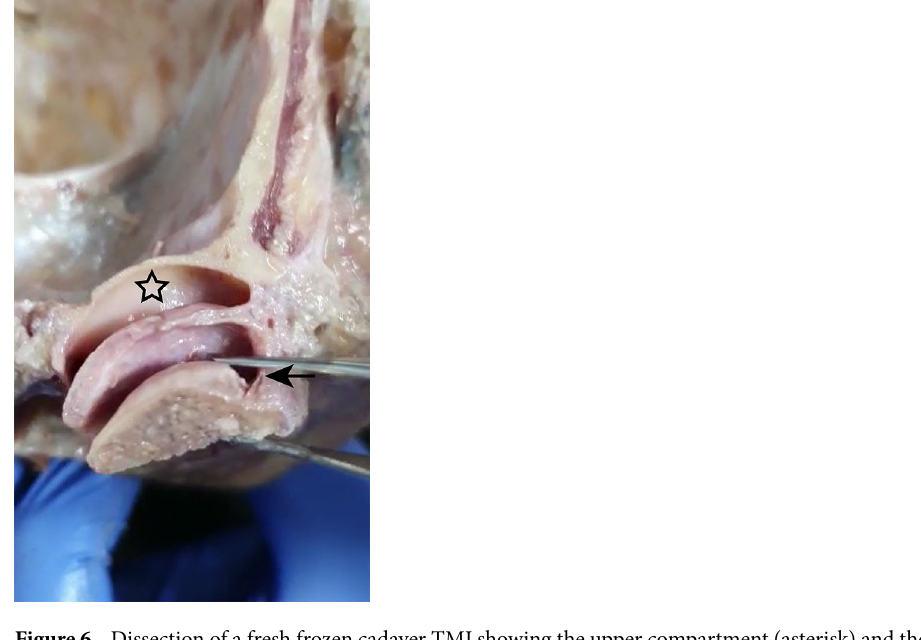
Figure 6. Dissection of a fresh frozen cadaver TMJ showing the upper compartment (asterisk) and the lateral infundibulum of the lower compartment (outlined